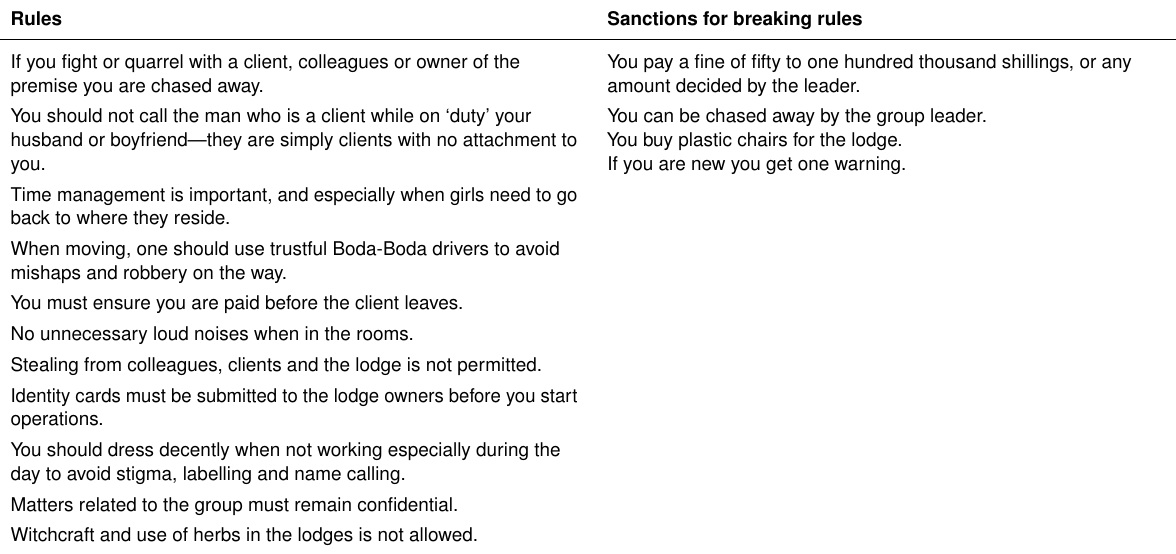
Table 4. Example of Rules and Sanctions for Female Aguu Prostitutes. Rules Sanctions for breaking